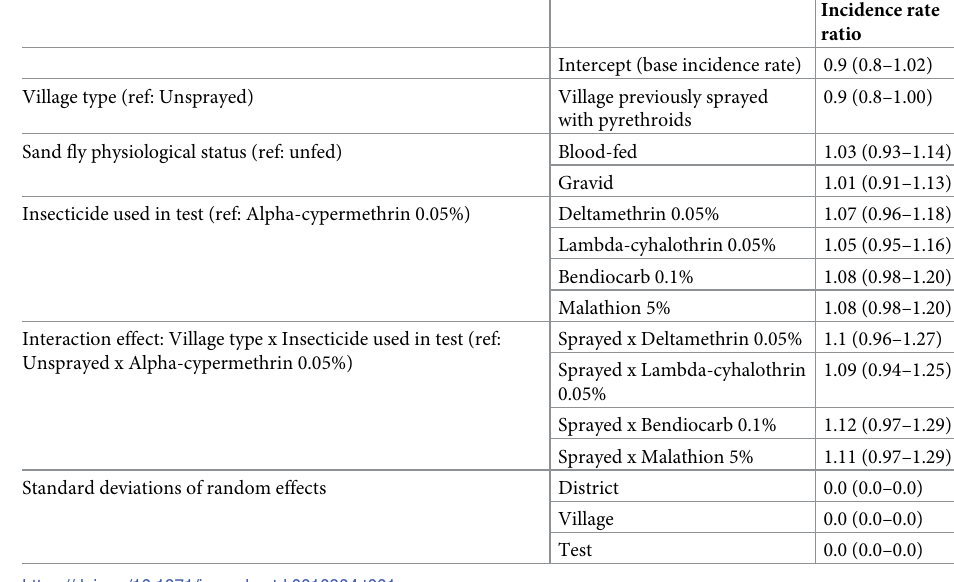
Table 1. Bayesian Poisson regression of the sand fly mortality rate in previously sprayed villages, sand fly subtype, and insecticide used in the susceptibility test, with interaction effects between village spraying and insecticide used, and 95% central credible